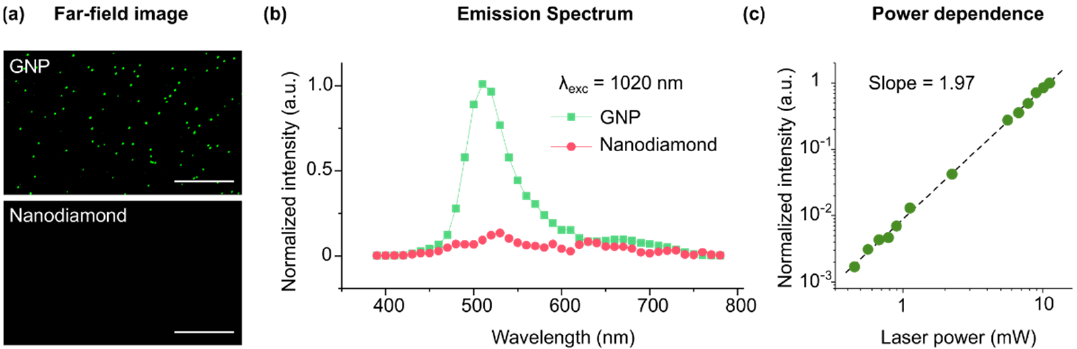
Figure 2. Multiphoton emission from single GNPs and nanodiamonds. ( a ) Far-field optical images obtained by multiphoton excitation of GNPs and nanodiamonds at λ = 1020 nm and ~1 mW excitation power. No detectable signal was observed in the nanodiamonds (at λ = 1020 nm and ~1 mW). Scale bars, 10 µm. ( b ) The corresponding average emission spectrum of the GNP and nanodiamonds. GNP emission was centered at 520 nm. ( c ) The emission intensity in GNP increases with excitation power almost quadratically (slope = 1.97 in the log scale).